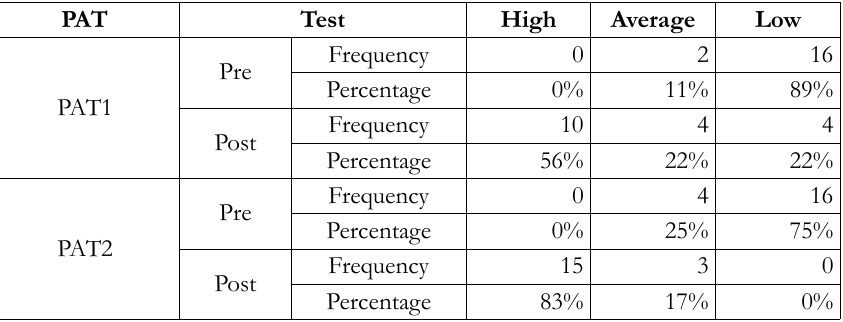
Table 5. Frequency and percentage distribution of learners